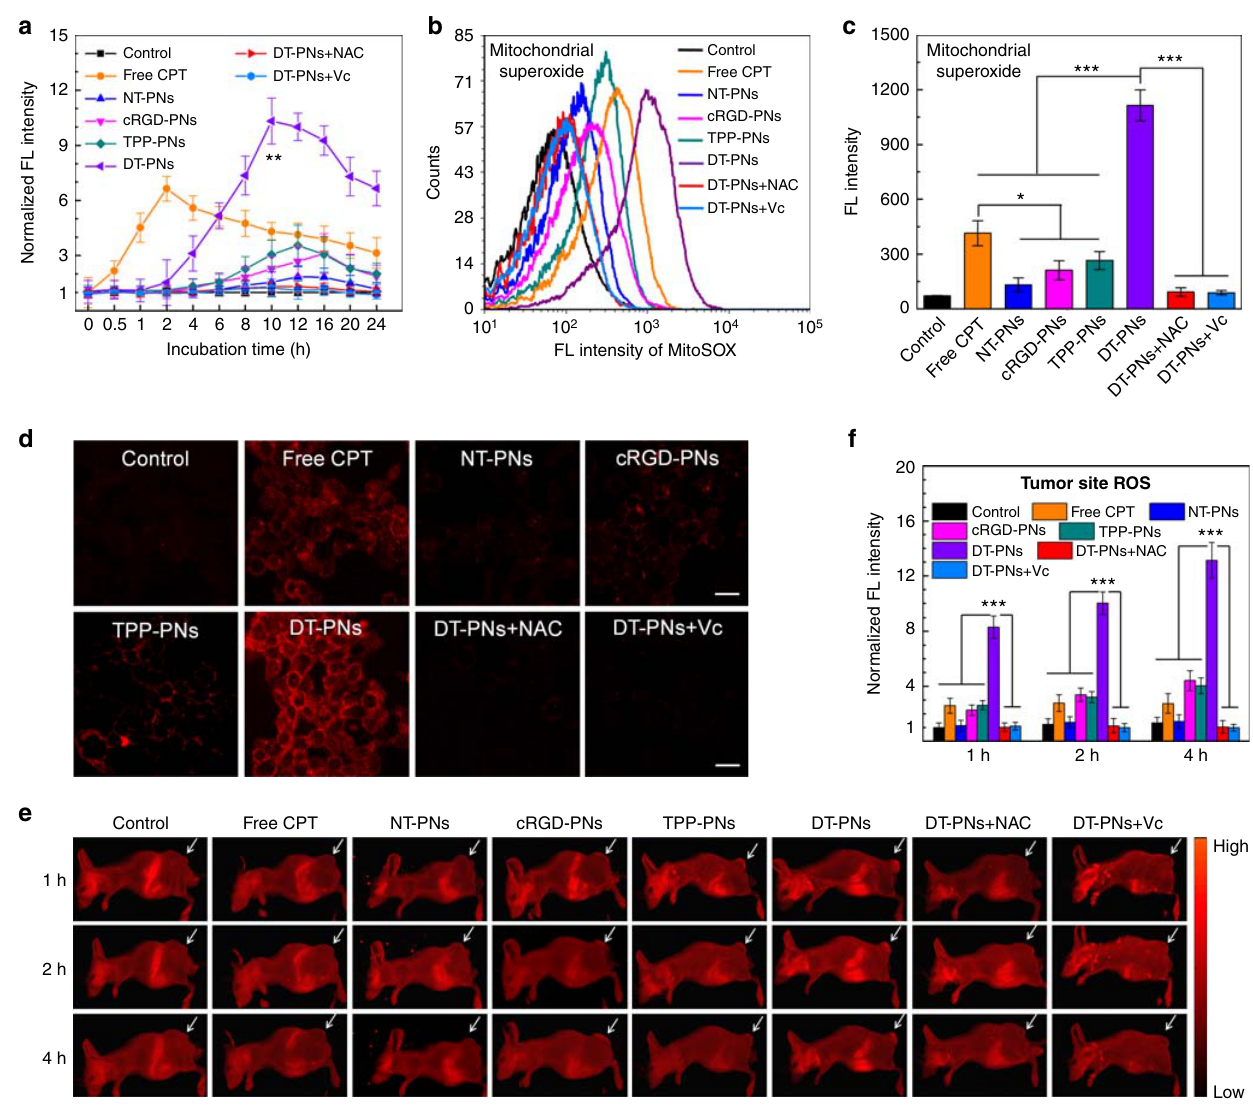
Fig. 5 In vitro and in vivo demonstration of ROS burst triggered by DT-PNs. a Time-dependent relative level of mitochondrial superoxide for 4T1 cells after diverse treatments within 24 h based on fl ow cytometry analysis (FCAS). MitoSOX Red was employed as a fl uorescent indicator of mitochondrial superoxide. The mean value was calculated by the t test (mean ± s.e.m. n = 3). ** p < 0.01, compared with the free CPT group. b Determination of superoxide in mitochondria upon different treatments for 8 h detected by MitoSOX based on FCAS. c Statistical analysis of the mean fl uorescence intensity in b . The mean value was calculated by the t test (mean ± s.e.m. n = 3). * p < 0.05, *** p < 0.001, compared with the indicated group. d CLSM imaging of mitochondrial superoxide by MitoSOX staining upon the same treatments in b (scale bar, 20 μ m). e In vivo fl uorescence imaging of 4T1 tumor-bearing Balb/c mice after intravenous injection with free CPT, NT-PNs, cRGD-PNs, TPP-PNs, and DT-PNs with/without 20 mM NAC or 10 mM Vc for 12 h, and followed by intraperitoneal injection with one ROS probe (Cellular Reactive Oxygen Species Detection Assay Kit, Deep Red Fluorescence), white arrows indicate the tumor sites. f Quantitative analysis for the fl uorescence intensity of tumor sites in e . The mean value was calculated by the t test (mean ± s.e. m. n = 3). *** p < 0.001, compared with the indicated